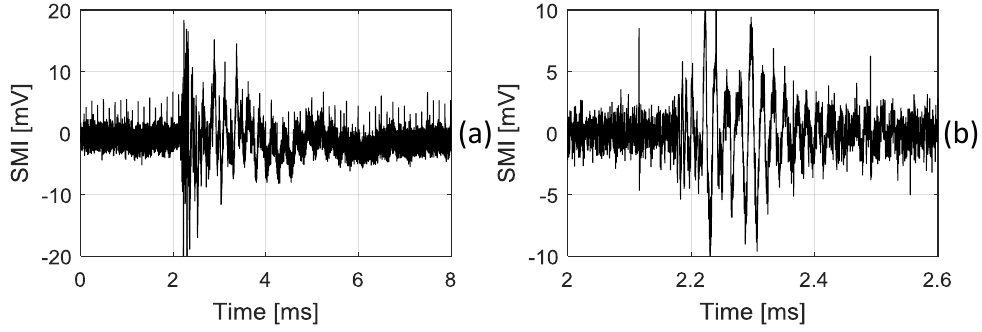
Figure 11. SMI signal corresponding to the AE wave generated by pencil lead breaking, ( a ) a raw detected SMI signal, ( b ) an SMI signal after filtering.